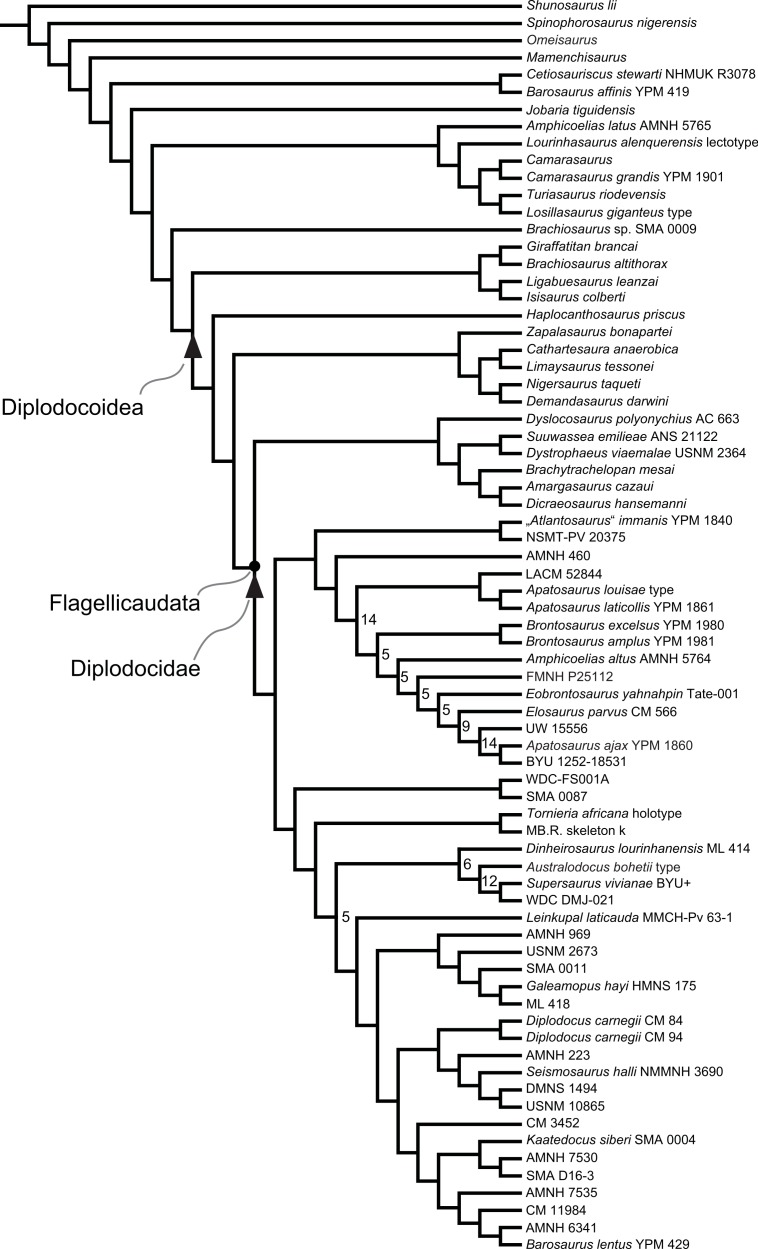
Reduced consensus tree obtained by implied weighting.Eight OTUs were deleted a posteriori. Numbers at the nodes indicate the number of changes between the two branches departing from the node (for the apomorphy count), where they differ from the trees under equal weights.